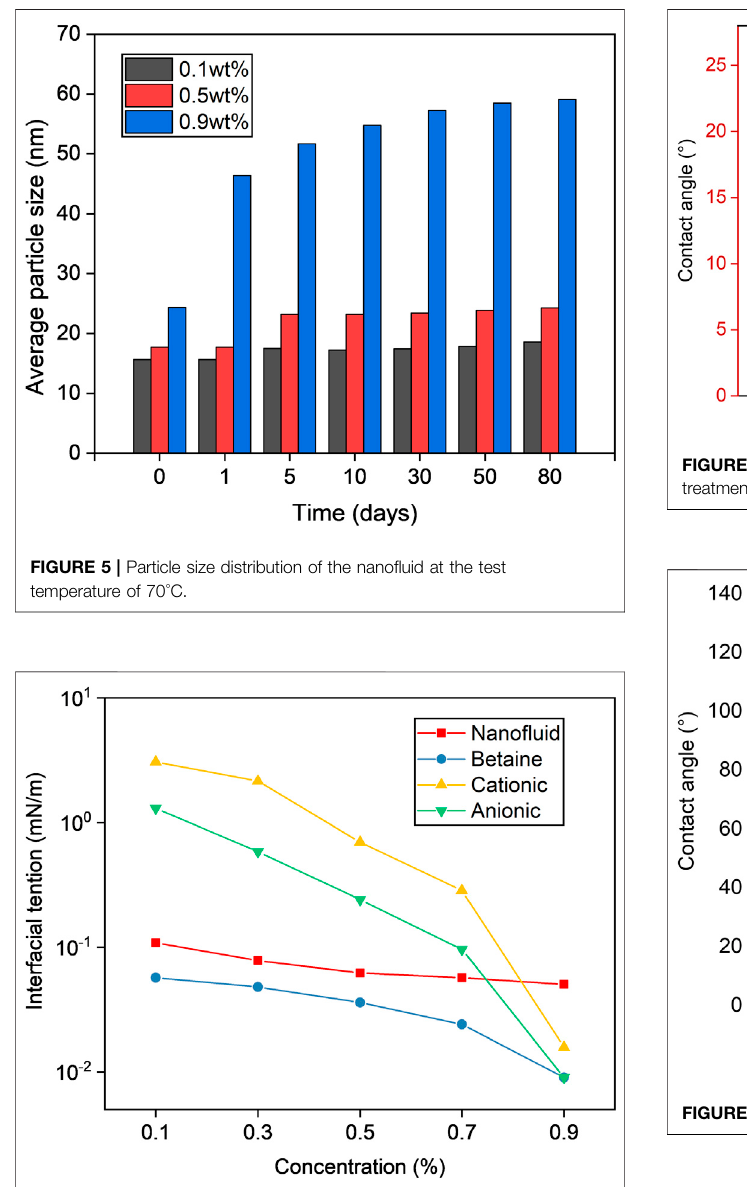
FIGURE 6 | Interfacial tension of four oil-displacing agents with different concentration.